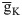
Spike threshold and corresponding biophysical basis produced by varying γw and g¯K.(A)-(C) summarize the results in the case of varying γw. The minimal model exhibit Type I excitability with γw = 10mV and Type II excitability with γw = 20mV. (D)-(F) summarize the results in the case of varying g¯K. The neuron exhibits Type I excitability with g¯K=7mS/cm2 and Type II excitability with g¯K=20mS/cm2. βw = 0mV for (A)-(C), and βw = -10mV, γw = 13mV for (D)-(F). Other parameters are as indicated in Materials and Methods. (A) and (D) show the activation curves and kinetics of ionic currents for two cell types. Increasing γw has no effects on Na+ activation m
∞, while it reduces the slope of K+ activation w
∞ and increases K+ time constant τ
w. Unlike γw, increasing g¯K has no impacts on the voltage-dependency and kinetics of I
K, while it affects the magnitude of K+ conductance (data is not shown). (B) and (E) give the membrane currents at the subthresholds for two types of neuron model. Increasing γw has no effects on I
Na and I
Leak, whereas it leads I
K,SS to activate prior to spike initiation. Increasing g¯K causes the outward I
K,SS to be much stronger without altering its voltage-dependency and kinetics. Both of them result in a much larger outward I
SS at the threshold. (C) and (F) give the spike threshold within a range of dV/dt for each cell. The dV/dt is from 0.8mV/ms to 4.5mV/ms. This is because Type II neuron generates the delayed loss of stability for dV/dt<0.8mV/ms, which leads to a big error when computing dV/dt. The specific reason is shown in the Discussion.